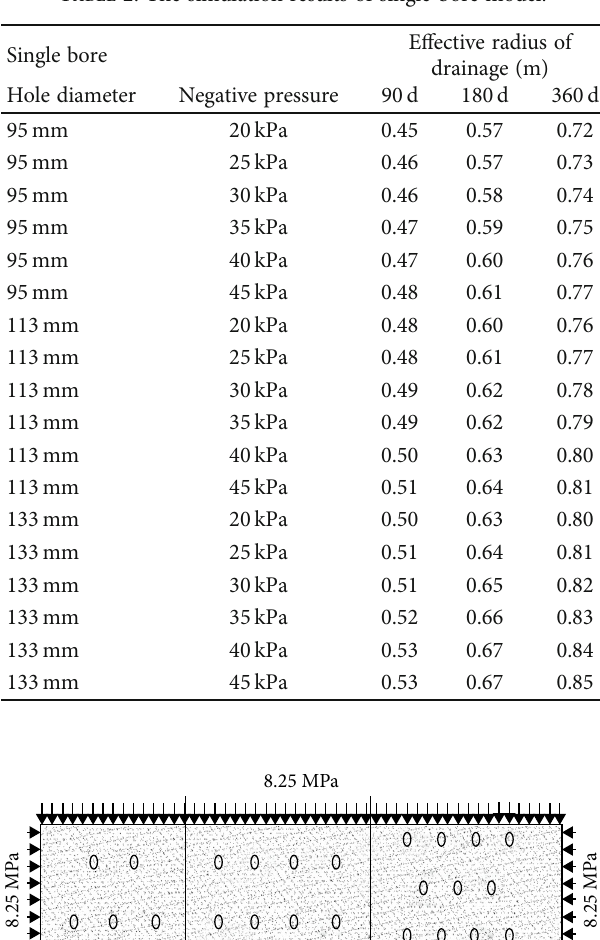
Table 2: The simulation results of single-bore model. Single bore